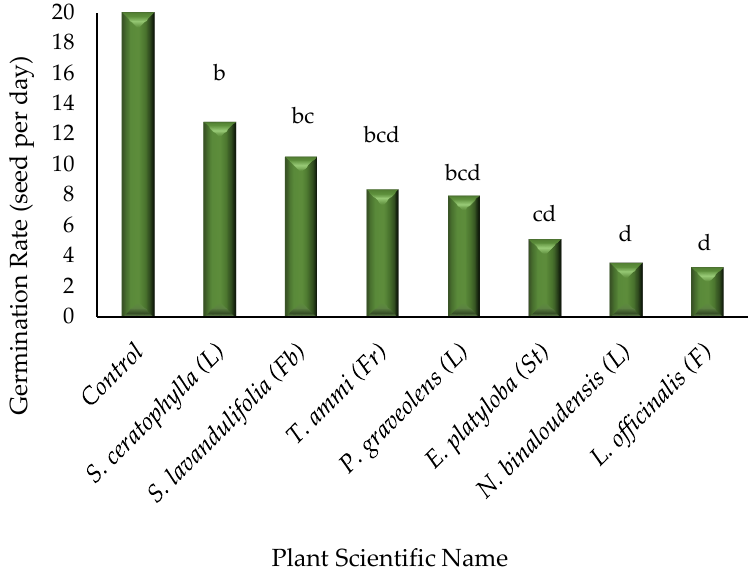
Figure 5. Effect of the most inhibitory plants on the germination rate of lettuce seeds. Columns followed by the same letter ( a.b,c,d,e ) are not significantly different (p ≤ 0.05) by Duncan’s multiple range tests.